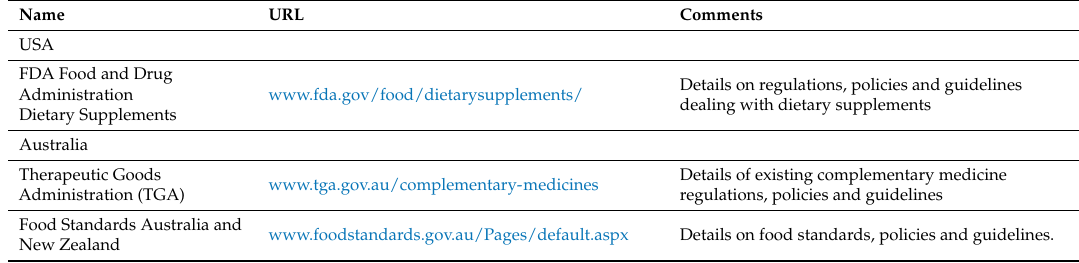
Table 1. Useful Global Resources on Dietary Supplement Regulatory Issues and